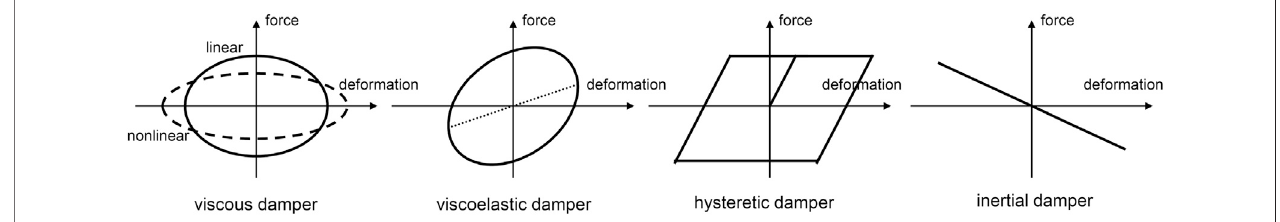
FIGURE 3 | Force-deformation relations of viscous damper (linear and nonlinear), viscoelastic damper, hysteretic damper and inertial mass damper.